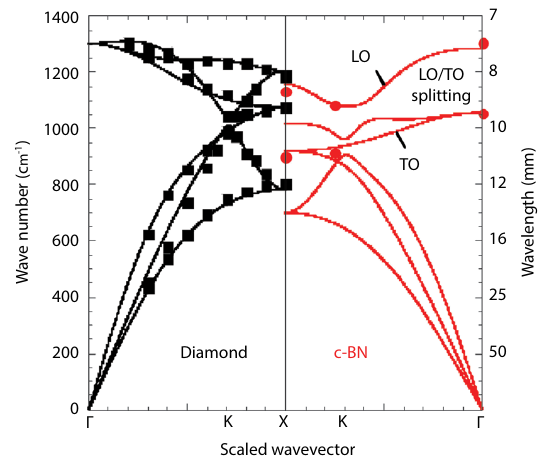
Figure 10 Calculated phonon dispersions in the Γ→ K → X high symmetry direction for diamond (black curves) and c-BN (red curves) with experimental data for diamond (black squares) [138] and c -BN (red circles) [139, 140]. c -BN has lower acoustic and TO frequencies than diamond due to weaker interatomic bonding, however, c -BN and diamond have similar LO frequencies due to the polar nature of the bonding in c